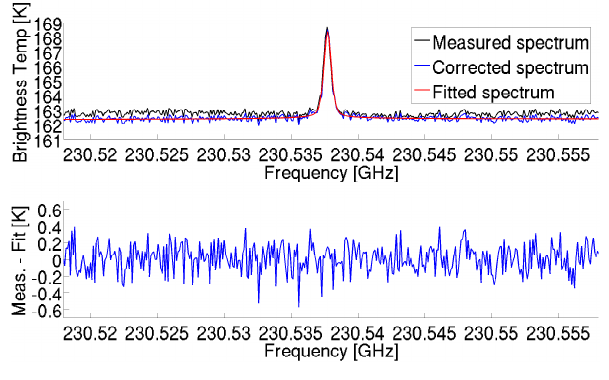
Fig. 2. Top panel: spectrum measured on 29 October 2009, 06:52h (black) and the same spectrum corrected for standing waves (blue), together with the fit calculated by the retrieval process (red). Bot- tom: the corresponding residuum (difference of the corrected spec- trum and the fitted spectrum), which contains only noise contribu- tions, showing that the CO line was fitted adequately.